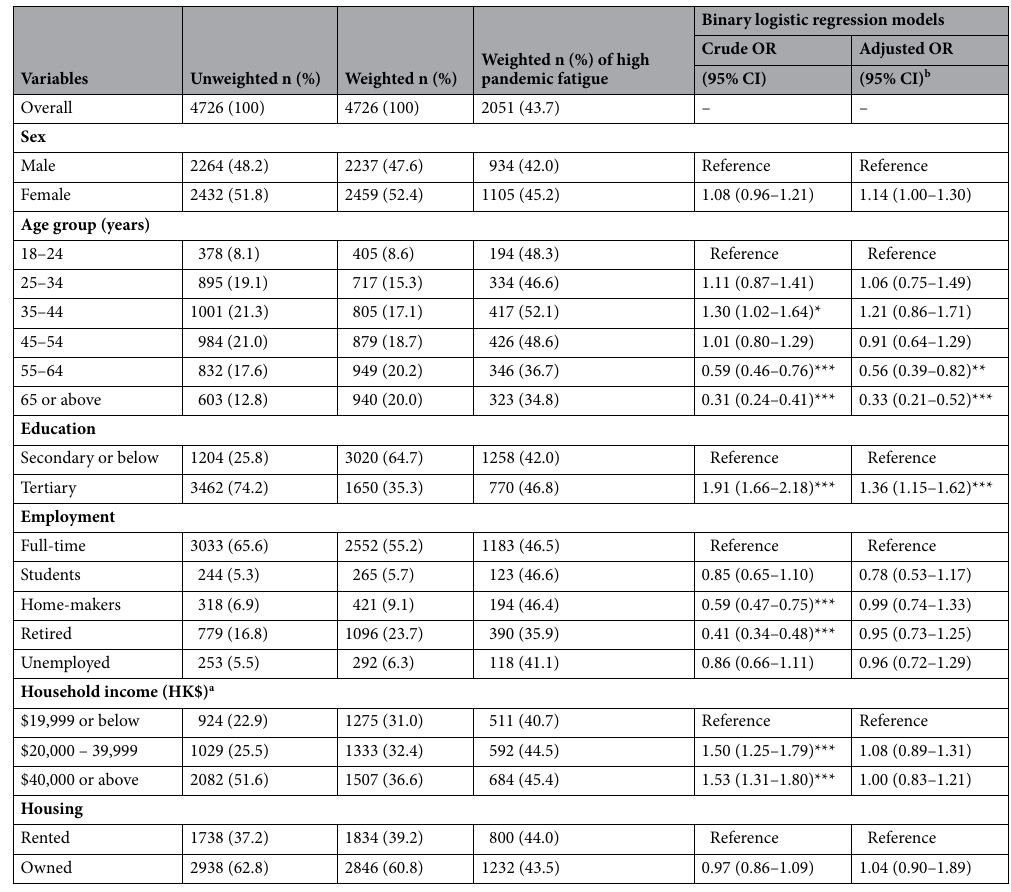
Table 1. Sociodemographic characteristics of the sample and their associations with high pandemic fatigue. a US$1 = HK$7.8. b OR adjusted for all sociodemographic variables. Missing data were excluded. Weighting was applied based on the distribution of sex, age, and education in the Hong Kong population 2020 census data. * P < 0.05, ** P < 0.01 *** P <